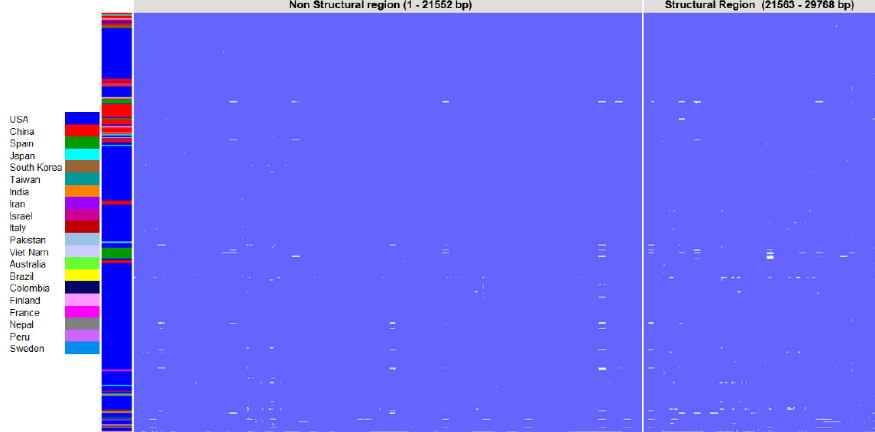
Figure 7. Multiple sequence alignment of 540 SARS-CoV-2 complete genomes. The graphical description of alignment of 540 genomes in a single window from Jalview workbench. The identical regions are masked with blue color and the variations highlighted in white color. The small white bars indicate the deletions in the genomes whereas dots indicate the single nucleotide variations. The 540 genomes are represented countrywise as color bars on the left side of the alignment. Variations between each pair of genomes were calculated by generating a pairwise distance matrix (File S4). The number of base substitutions per site was calculated for each pair of the 540 genome sequences. All ambiguous positions were removed from each sequence pair (pairwise deletion option). A total of 30,291 positions were identified and the values are represented as a heat map (Figure 8) and the corresponding R-code is provided in the supporting information as File S7. The observations from the distance matrix were consistent with the phylogeny where a large number of genomic variations were observed in the USA strains, representing genomic divergence.